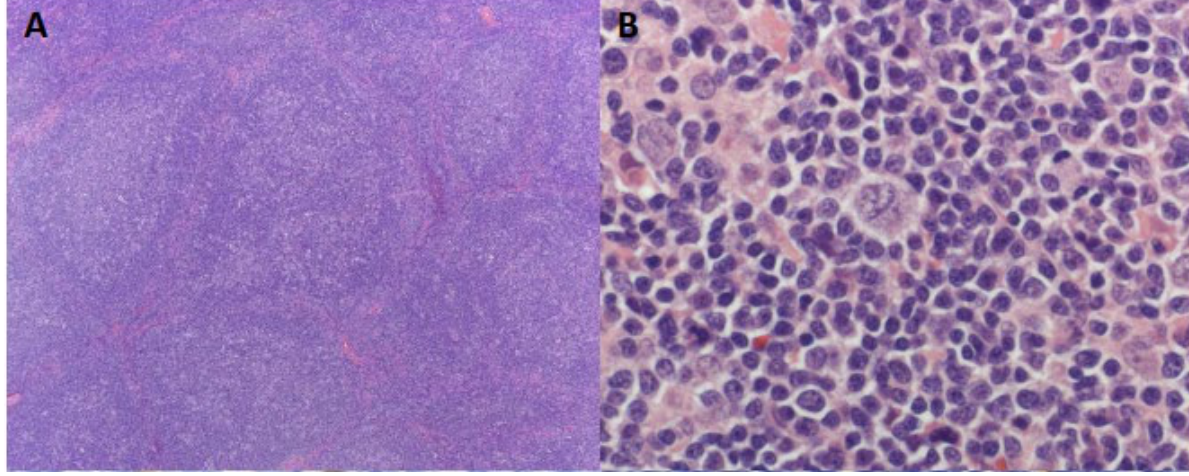
Figure 3. Histological and immunohistochemical features of nodular lymphocyte-predominant HL (NLPHL). ( A ) Vague nodular architecture is observed. ( B ) Scattered neoplastic cells feature polylo- bated (popcorn-like) nuclei, and are called lymphocyte-predominant (LP) cells. ( C ) LP cells show strong PAX5 expression. ( D ) LP cells lack PD-L1 expression (assessed using clone SP142). ( E ) LP cells are ringed by PD-1-positive “rosetting” T lymphocytes. 3.3. Cellular Origin and Molecular Biology Genetic analysis of isolated LP cells has revealed clonal IG gene rearrangement, and ongoing somatic hypermutation [112], indicating that LP cells are derived from GC B cells.